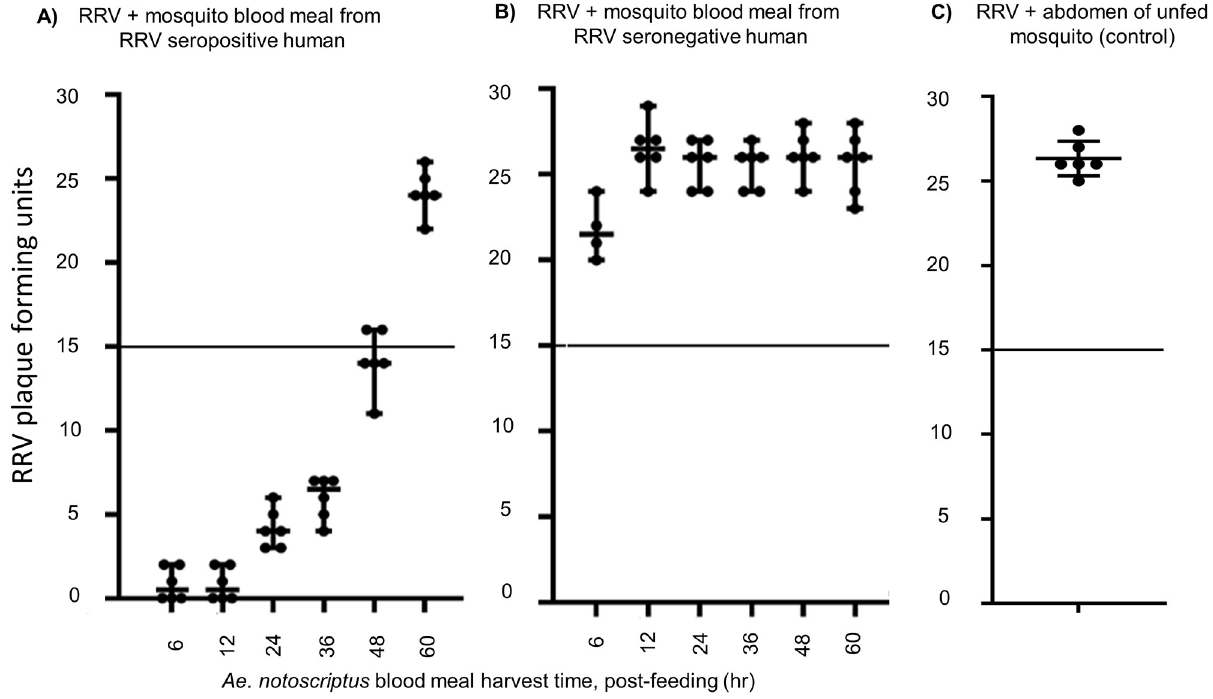
Fig 5. Impact of post-feeding times on neutralisation of RRV. Blood meals from an RRV seropositive human volunteer (A), blood meals from an RRV seronegative human volunteer (B) and unfed mosquito abdomens as a control (C). Antibody positive blood meals continued to neutralise � 50% of plaques until 48 hours